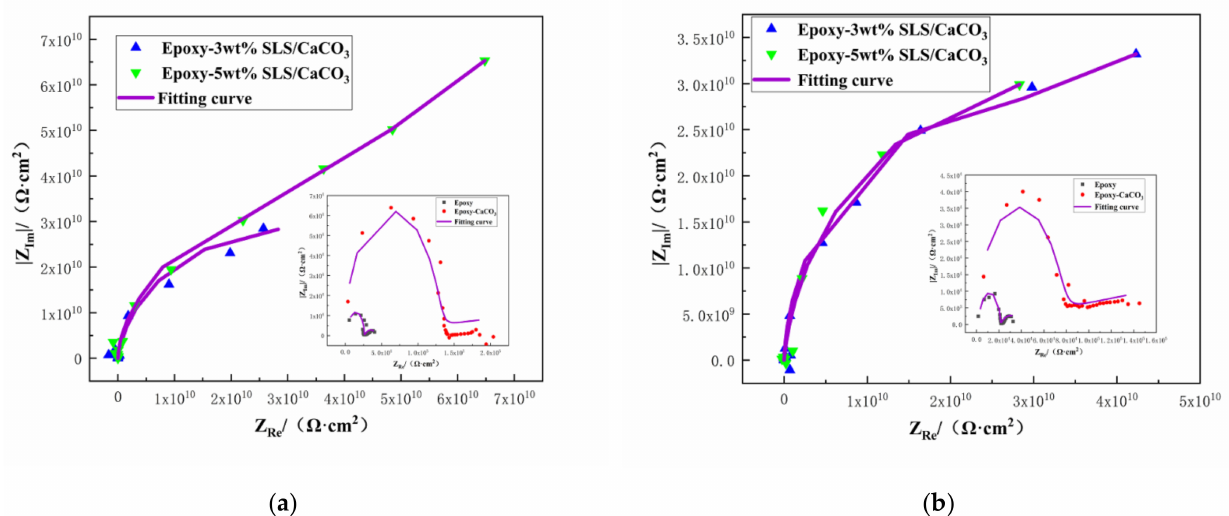
Figure 10. Nyquist plots for Q235 steel covered by epoxy coatings containing CaCO 3 microparticles with or without SLS as well as the pure epoxy coating after exposure to the SCP solution ( a ) 5 days and ( b )15 days.